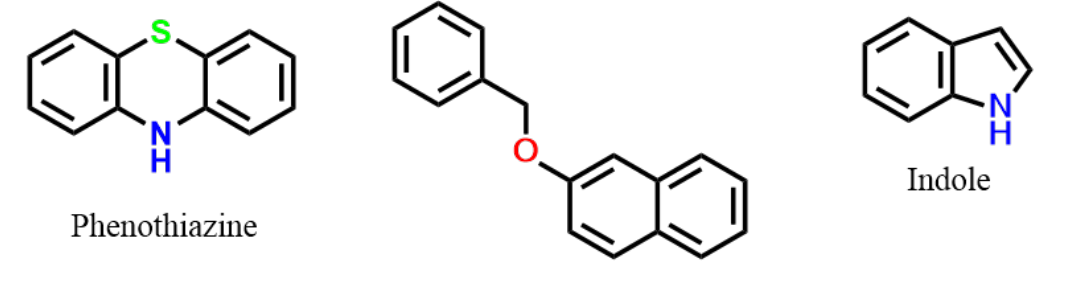
Figure 11. Examples of aromatic molecules that eluted to the Aro-3 fraction that would have otherwise eluted in the Aro-2 fraction if the heteroatoms were replaced by carbon atoms. (The green color designates sulfur atom, the blue color—NH group, and the red color—oxygen atom.)